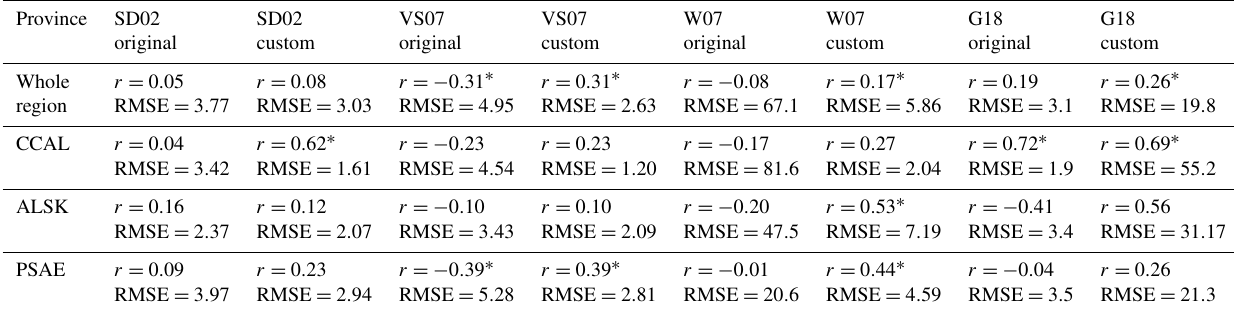
Table 5. Pearson correlation coefficients and root-mean-square errors (nmolL − 1 ) between observed DMS concentrations and empirical pre- dictions derived from the SD02, VS07 and W07 algorithms, using both published coefficients (original) and coefficients derived specifically for our NESAP observations using a least-squares approach (custom). Algorithm performance is shown for full NESAP region as well as the three Longhurst biogeographical provinces within our study area ( ∗ indicates significance of p